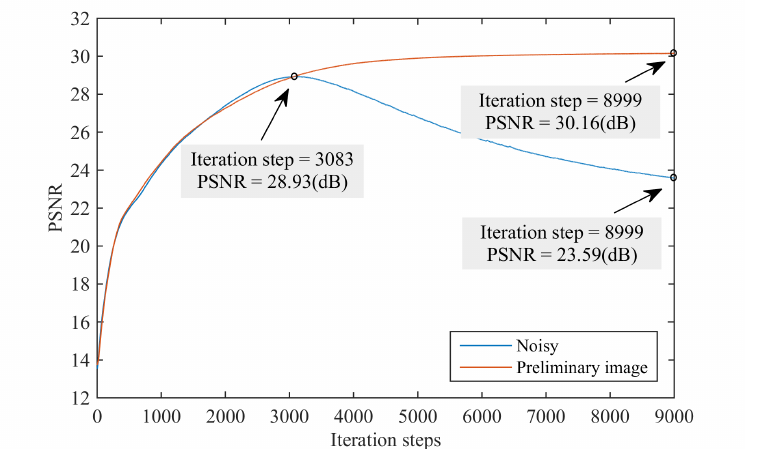
Figure 1. Learning curves for the reconstruction task using natural and noise images. PSNR of a natural looking image is higher compared to that of the noise